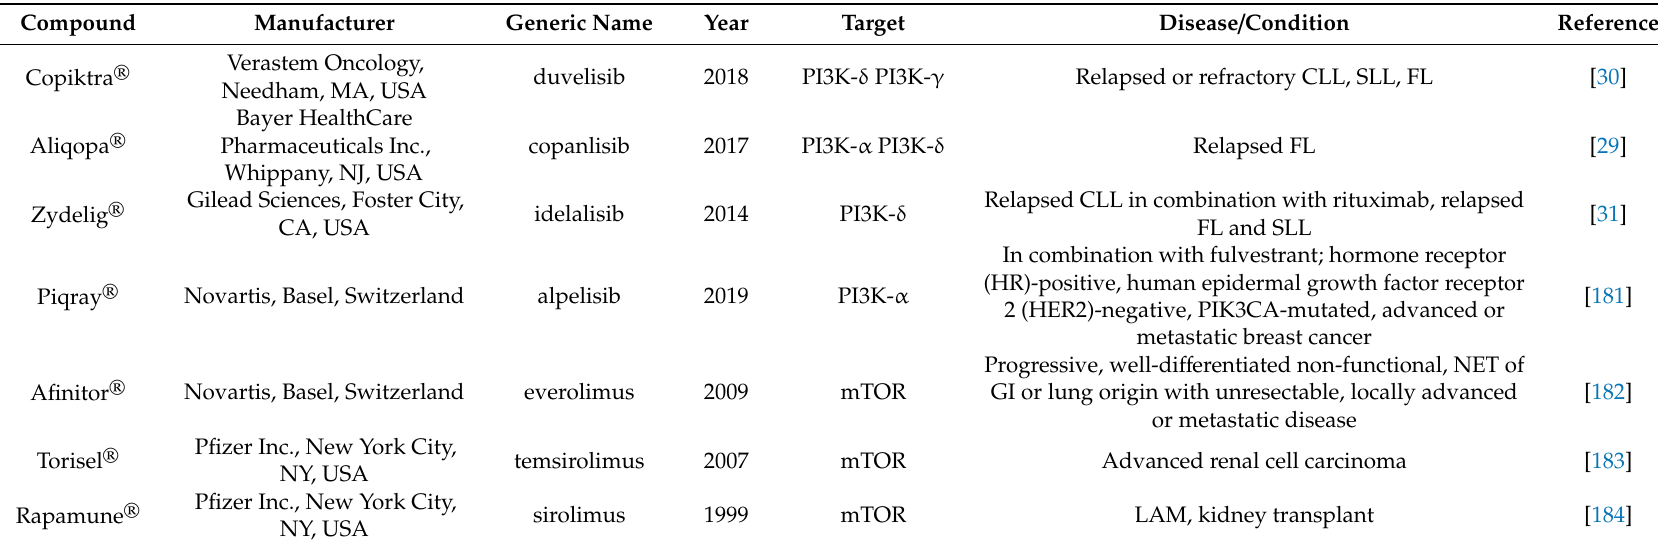
Table 1. PI3K and mTOR inhibitors approved by FDA for human cancers.